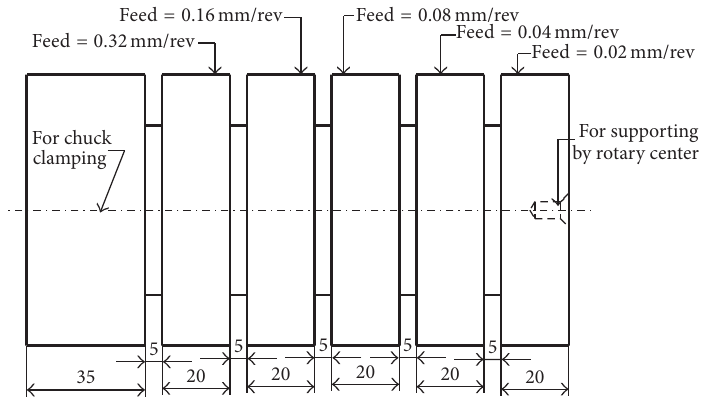
Figure 1: Test specimen drawing.